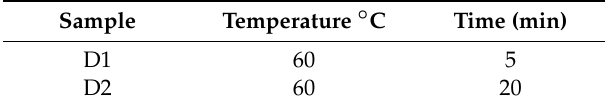
Table 3. Reactions conditions used in method D (power 900 W and frequency 2455